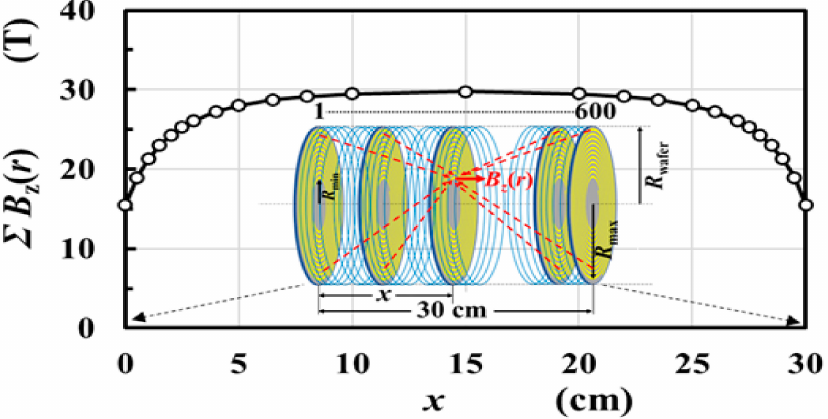
Figure 9. The sum of the contributions, B z ( r ), of all the wafers in a stack, Σ B z ( r ), as a function of the position of the wafer x in the stack in a typical case of m = 600. R min = 19.0